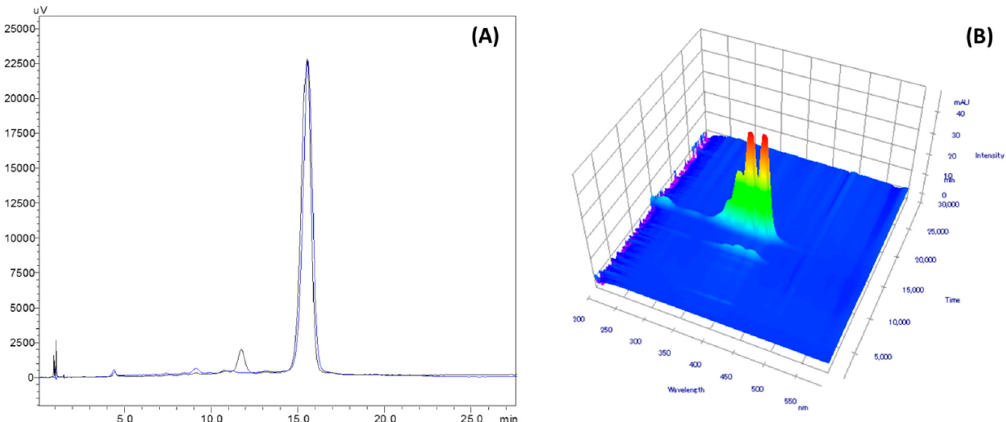
Figure 2. ( A ): Reference chromatogram at 408 nm of a 25 µg/mL amphotericin B base (blue curve) and deoxycholate (black curve) solution and with diode array detector screening ( B ). µV and mAU: units of intensity of signal measured by the UV-visible detector.